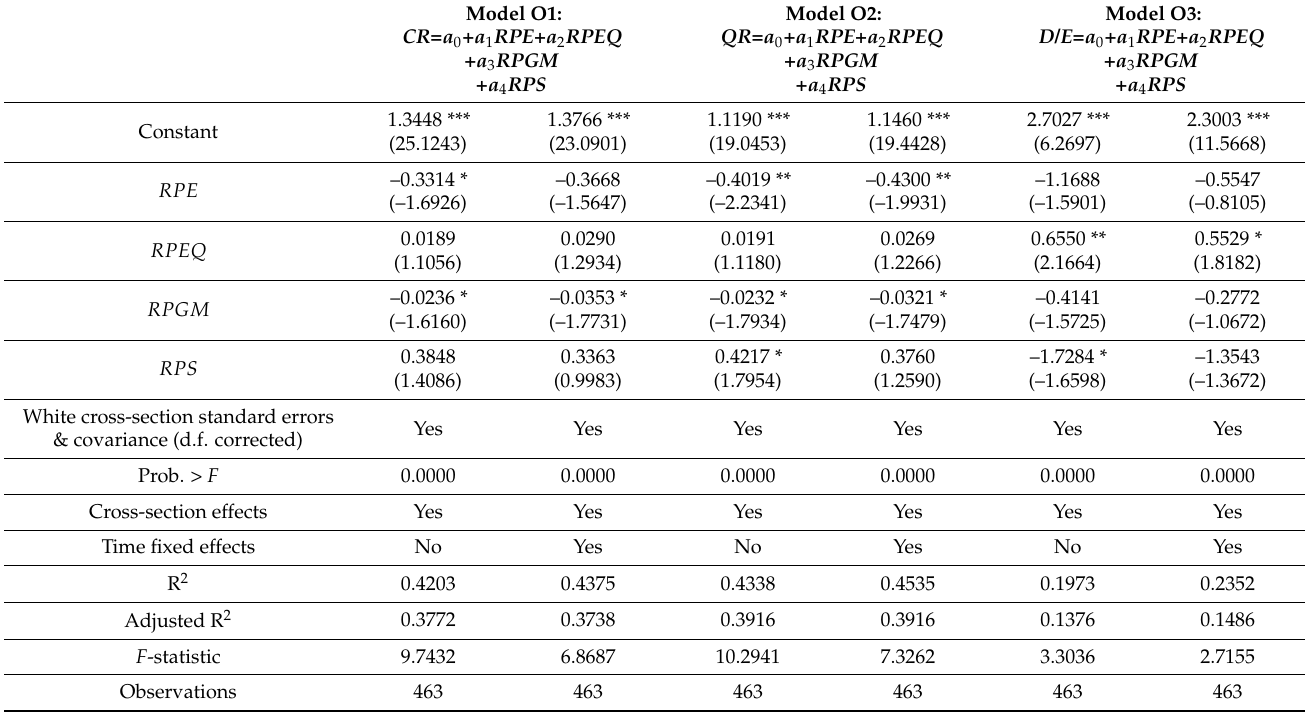
Table 12. Econometric models corresponding to the dependent variables CR , QR , and D/E for oil